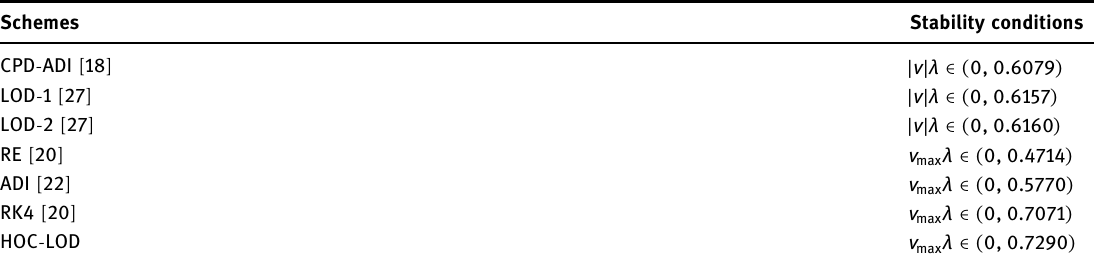
Table 1: The stability conditions of various di ff erence schemes for the 3D wave equations